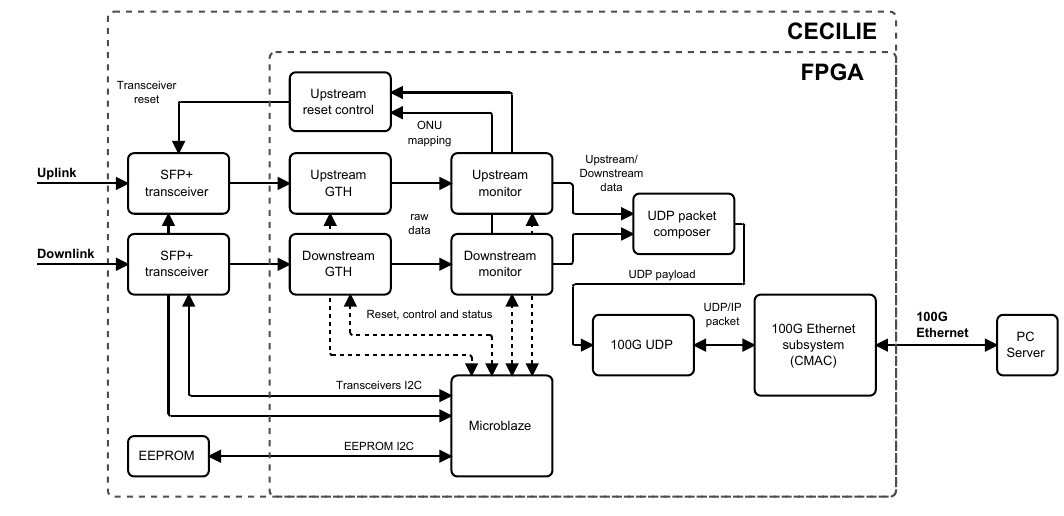
Figure 3. The internal configuration of Cecilia